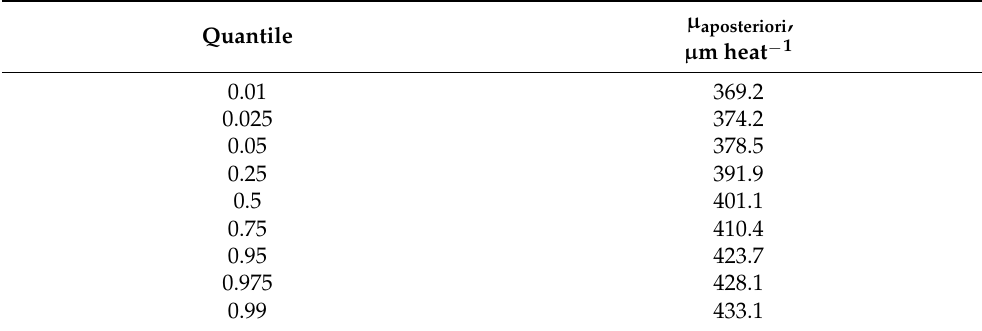
Table 2. Selected quantile values for the unit refractory wear rate in the slag spout zone calculated from the a posteriori